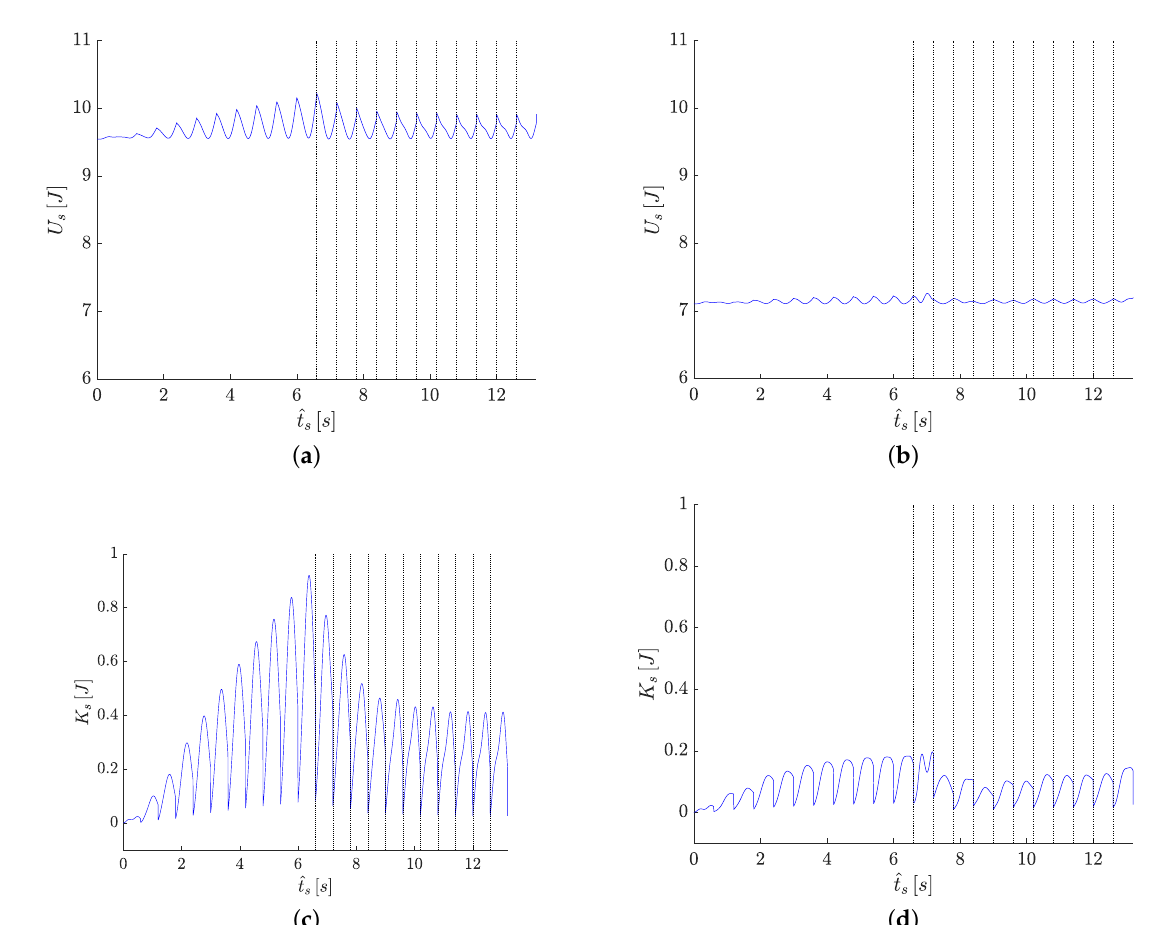
Figure 10. Behavior of the SPBR mechanical energy along the PWS and SPWS. Potential energy U s : ( a ) S-C design. ( b ) Sequential design. Kinetic energy K s : ( c ) S-C design. ( d ) Sequential